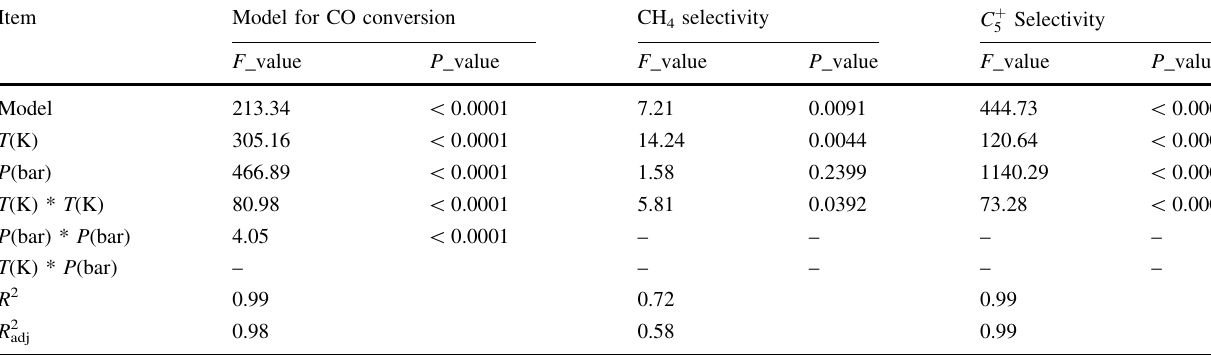
Table 2 Analysis of variance and regression coefficient of the RSM modeling